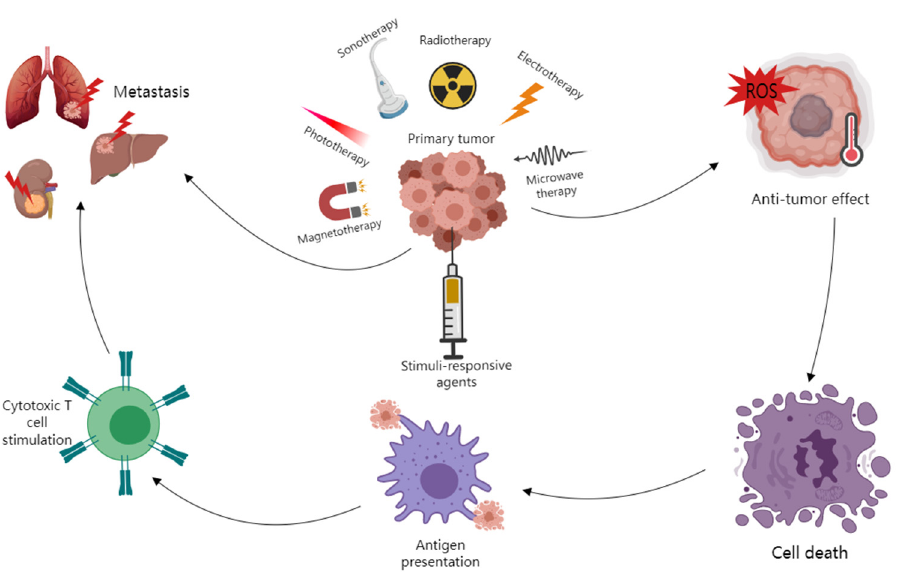
Figure 1. Demonstration of external stimuli ‐ responsive therapies. External stimuli such as light, radiation, microwave, alternative magnetic field (AMF) and ultrasound (US) induce the generation of heat or reactive oxygen species (ROS), thus resulting in tumor death. Antigens are released upon tumor death and captured by antigen ‐ presenting cells, which further trigger cytotoxic immune cell activation against metastatic tumors.